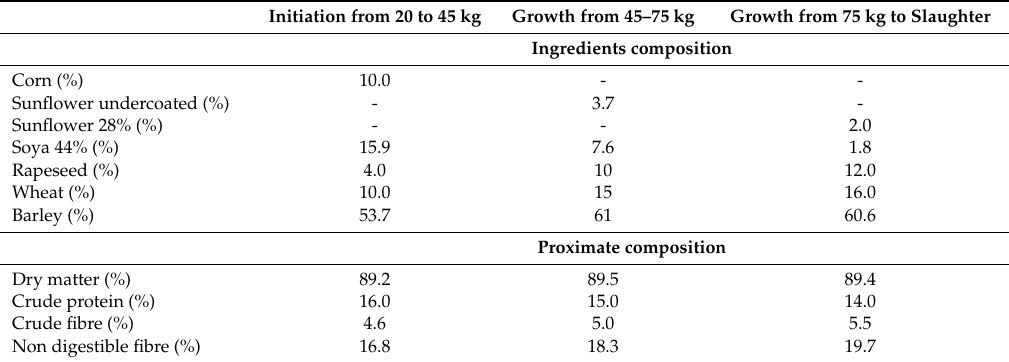
Table 1. Composition of basic feedstu ff that is used in the experiment. Initiation from 20 to 45